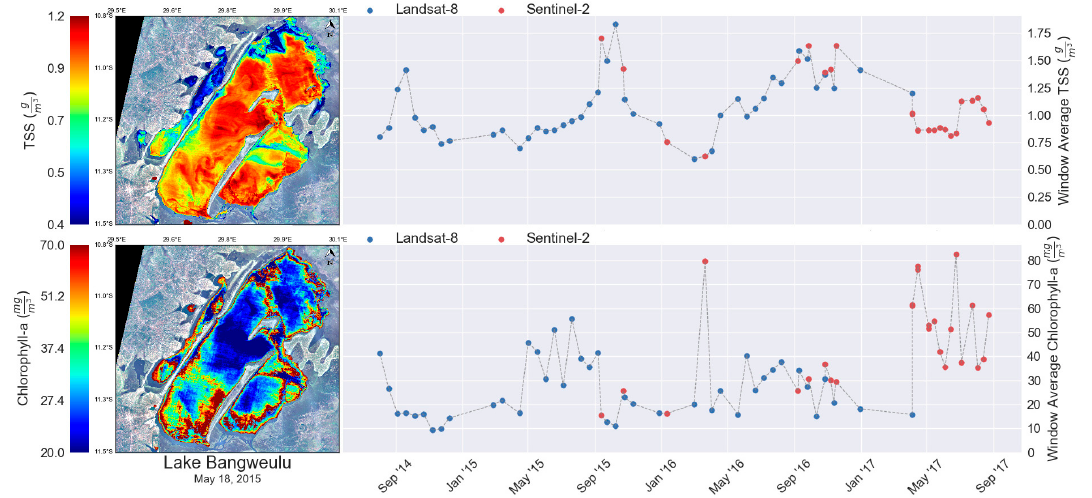
Figure 13. Time-series of lake-wide average TSS (g/m 3 ) and Chl (mg/m 3 ) products shown for Lake Bagweulu in the 2014–2017 period. TSS has a seasonal pattern with peaks in September/October. A peak in Chl is captured by Sentinel-2 data during late March 2016 and in April and July 2017.